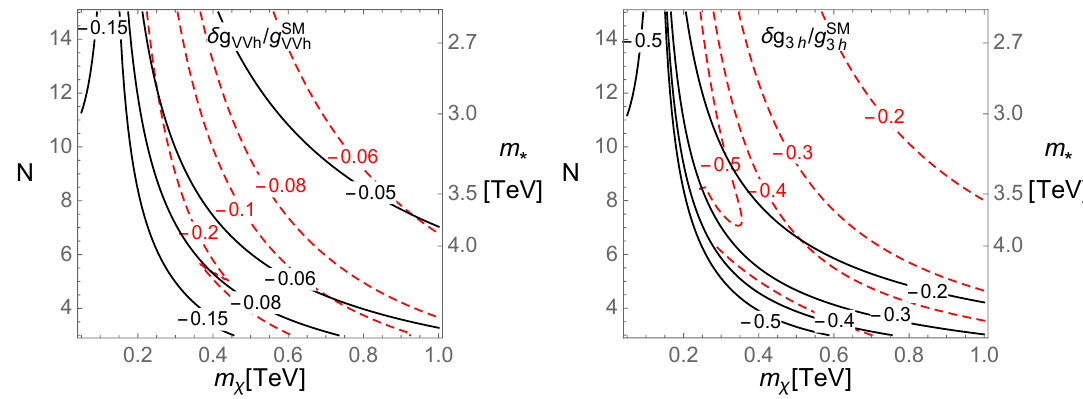
Figure 15 . Relative deviation of the Higgs couplings to electroweak gauge bosons (left panel) and of the triple Higgs coupling (right panel) for a meson-like dilaton (red dashed) and a glueball-like dilaton (black solid). Future (1 (cid:27) ) sensitivity to the former is expected to be 0.8% at CLIC [75] and 0.15% at FCC [76], while the expected precision for the latter is order-one at the high-luminosity LHC [77] and 10 (cid:0) 40% at future leptonic colliders [68,